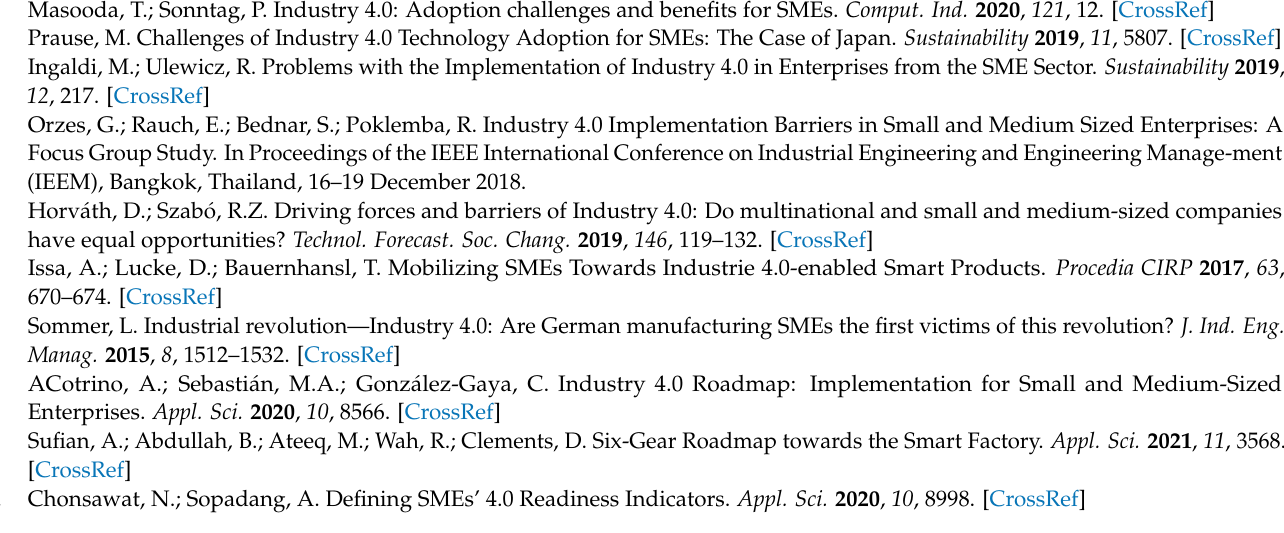
Table 2. Comparison between Industry 4.0 HUB, DIH, and Plattform Industrie 4.0.